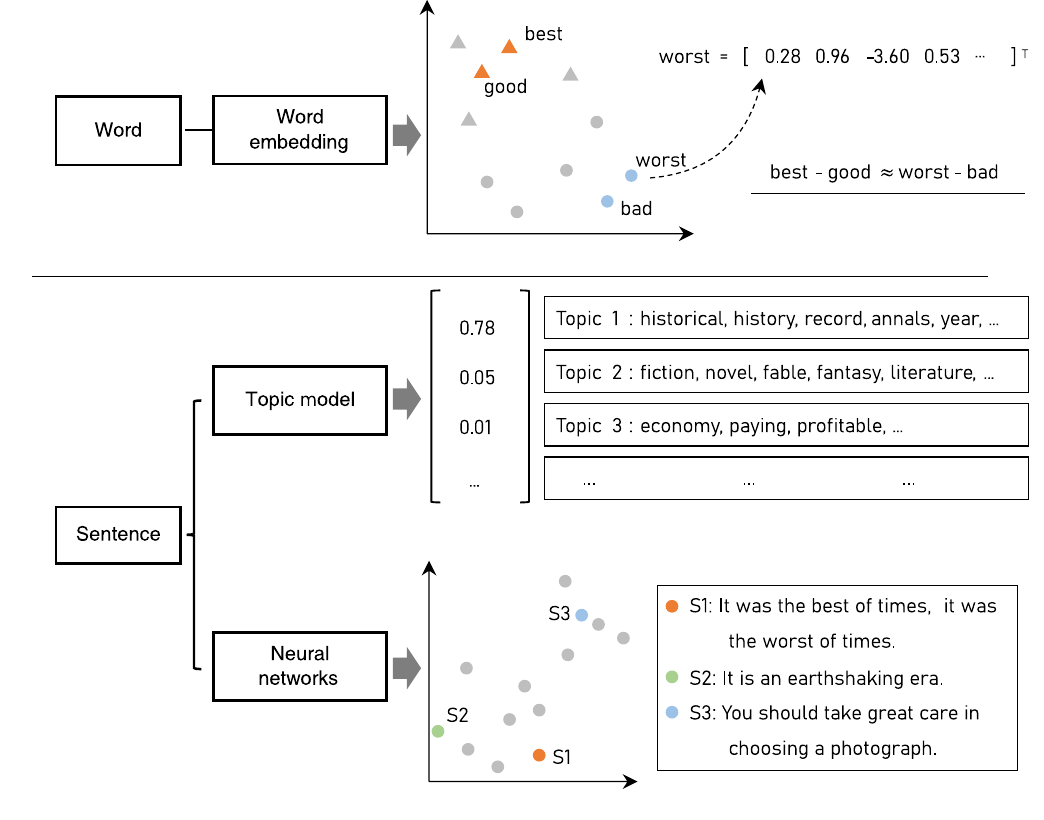
Fig. 7 An illustration of embedding-based representation of text.